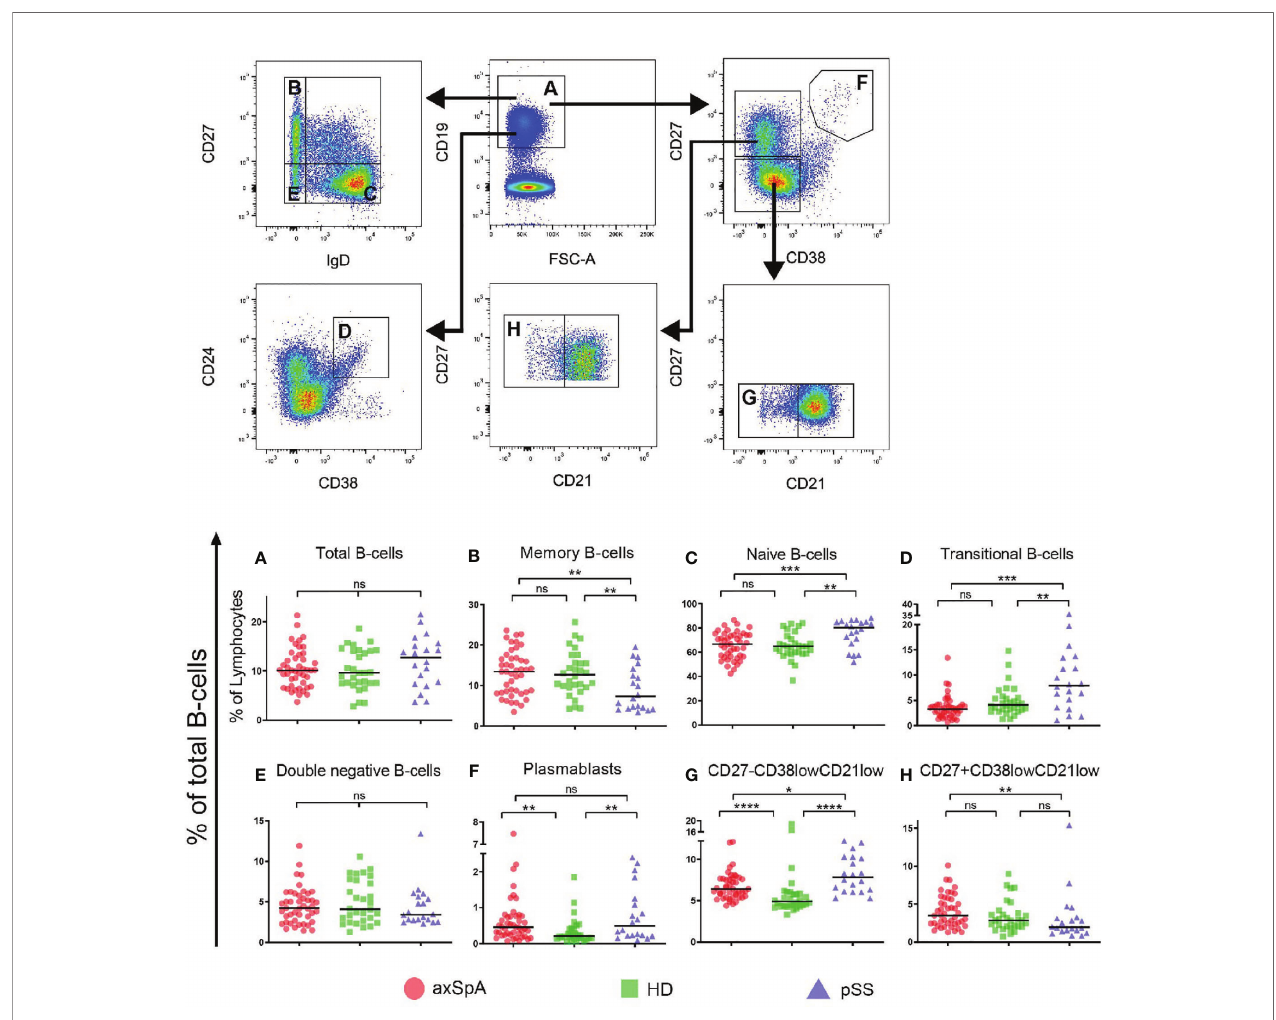
FIGURE 1 | Frequencies of total B-cells and B-cell subsets in patients with axSpA, pSS and healthy donors. Global gating strategy is shown with arrows pointing towards the next level of gating. Frequencies of (A) total B-cells (CD19 + ), relative to total lymphocytes, and the following B-cell subsets, relative to total B-cells, are shown: (B) memory B-cells (CD27 + IgD - ), (C) double negative (CD27 - IgD - ) B-cells, (D) naïve (CD27 - IgD + ) B-cells, (E) plasmablasts (CD27 + CD38 hi ), (F) transitional (CD24 hi CD38 high ) B-cells, (G) CD27 + CD38 low CD21 low B-cells and (H) CD27 - CD38 low CD21 low B-cells. Patients with axial spondyloarthritis (axSpA; n = 45) are indicated with red circles, healthy donors (HD; n = 30) are indicated with green squares and patients with primary Sjögren ’ s Syndrome (pSS; n = 20) are indicated with blue triangles. *P < 0.05, **P < 0.01, ***P < 0.001, ****P < 0.0001, ns, not signi fi cant and horizontal lines indicate the